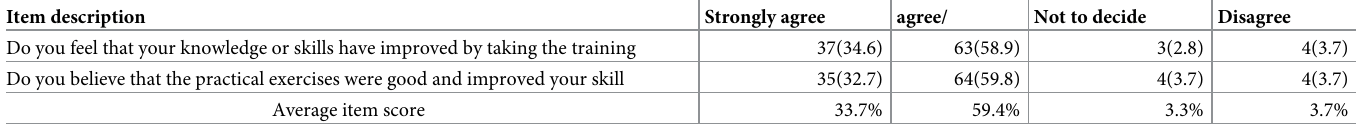
Table 5. Improvement in trainee’s knowledge and skills after attending training in Amhara Public Health Institute Dessie Branch, northeast Ethiopia, October/ 2019 (N = 107). Item